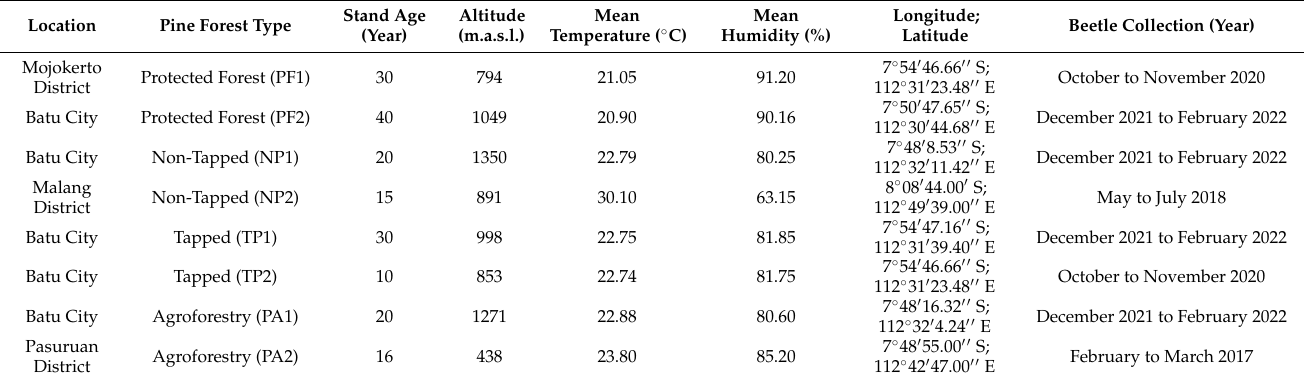
Table 1. Characteristics of the studied pine forests in East Java, Indonesia.